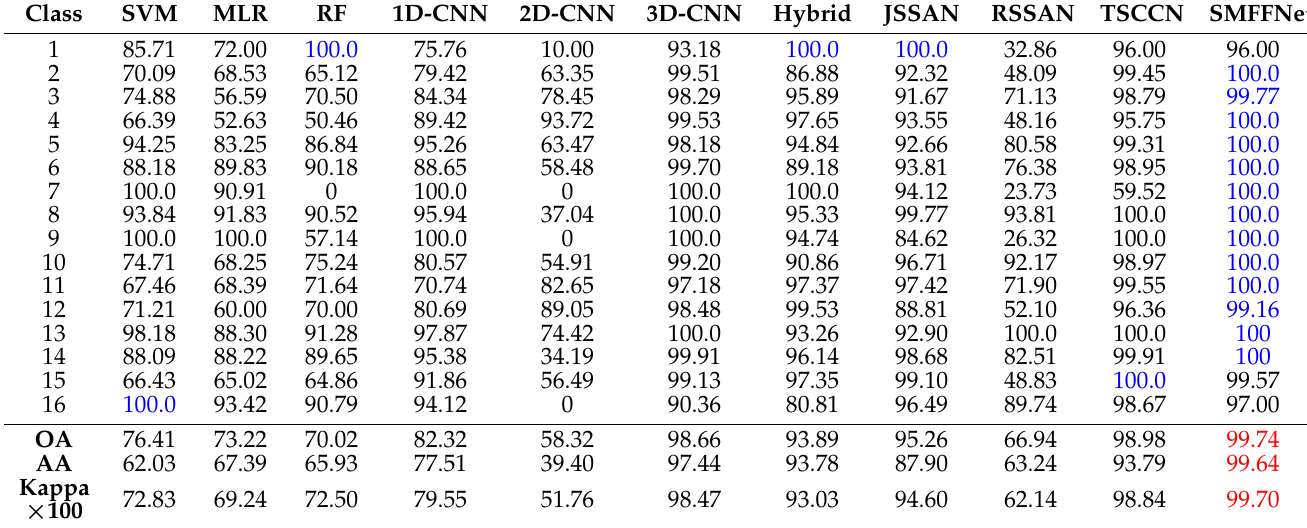
Table 6. Classification results of different methods for the IN dataset.